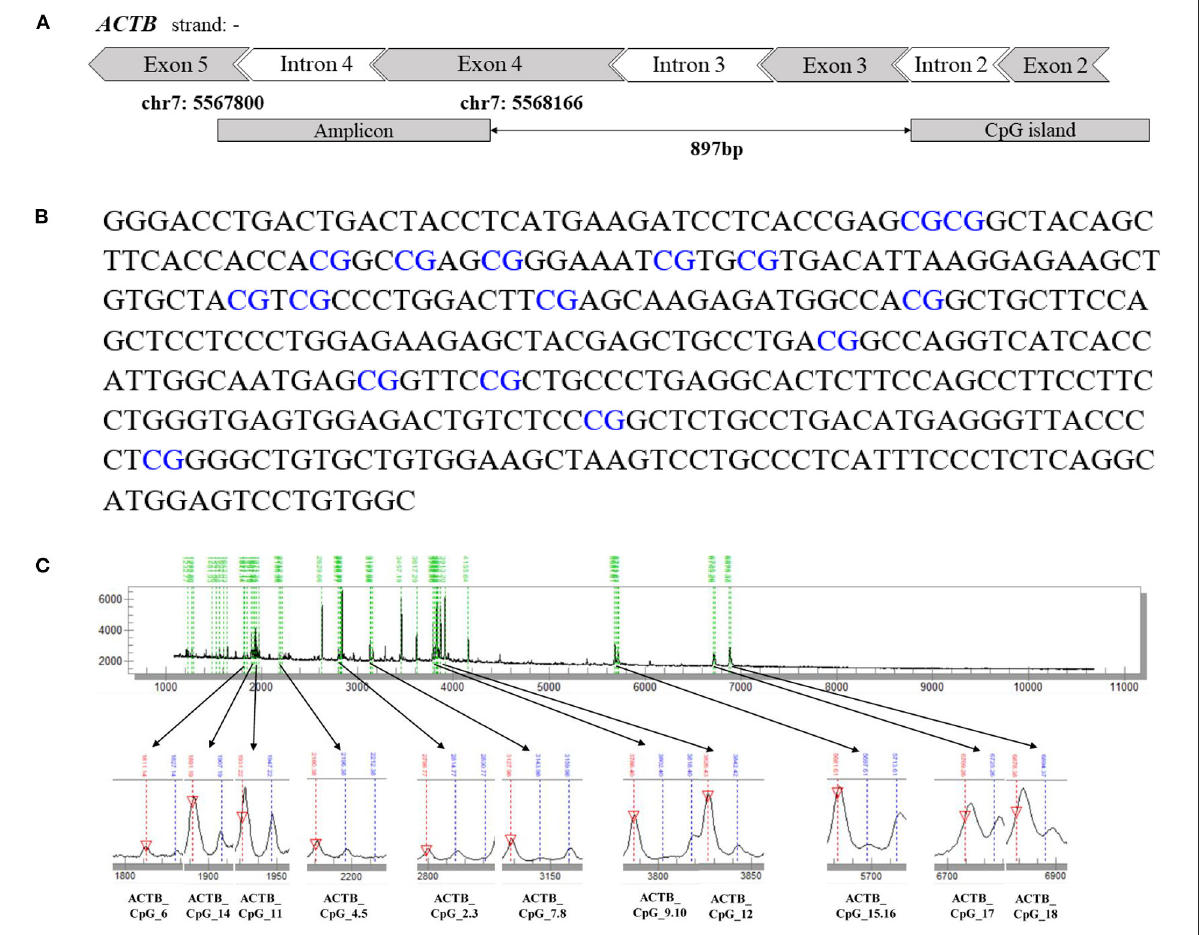
FIGURE1 The schematic diagram, sequence and the mass peaks of ACTB amplicon. (A) The location of the investigated 367 bp amplicon in ACTB (from the UCSC Genome Browser). (B) The sequence of the ACTB amplicon examined by the EpiTyper assay (chr7: 5567800–5568166, build 37/hg 19, defined by the UCSC Genome Browser). The 16 measurable CpG sites are depicted in blue. (C) The MassARRAY assay yielded 11 distinguishable peaks. The downward red arrow pointing at the signal peak indicates the completely non-methylated CpG site, and the blue line above the signal peak indicates the methylated CpG site. The sample mass of the signal peak is represented at the